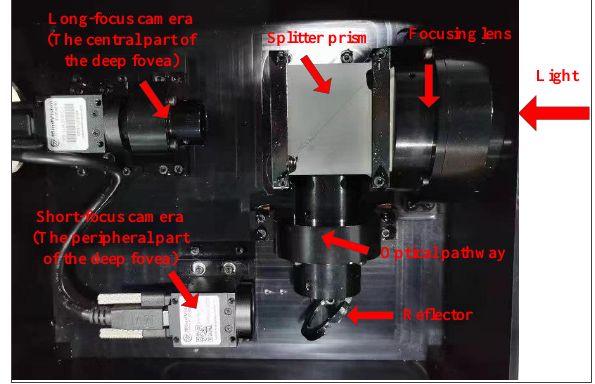
Figure 6. The designed optical imaging